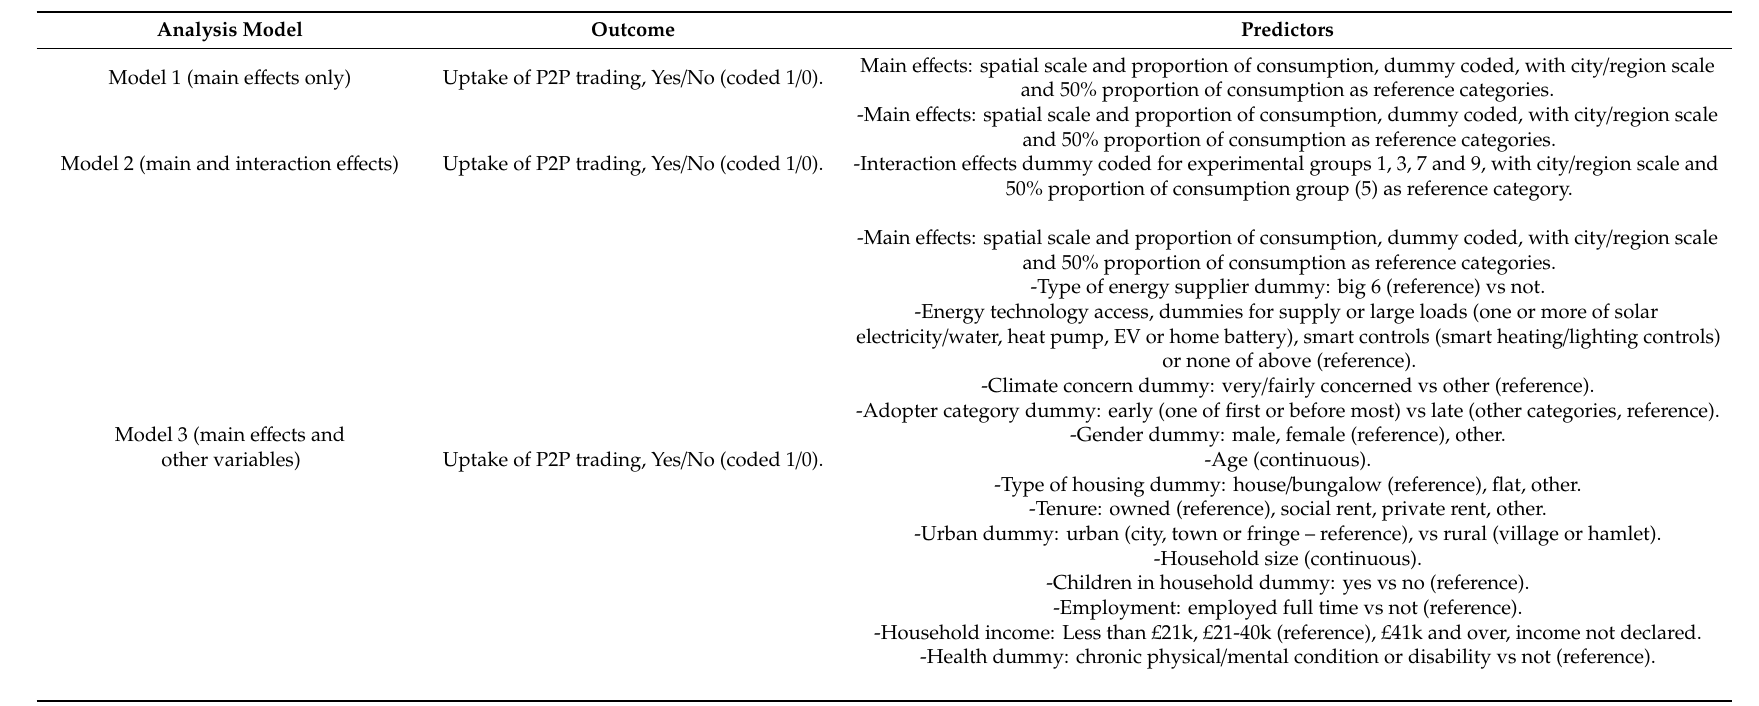
Table 3. Analysis